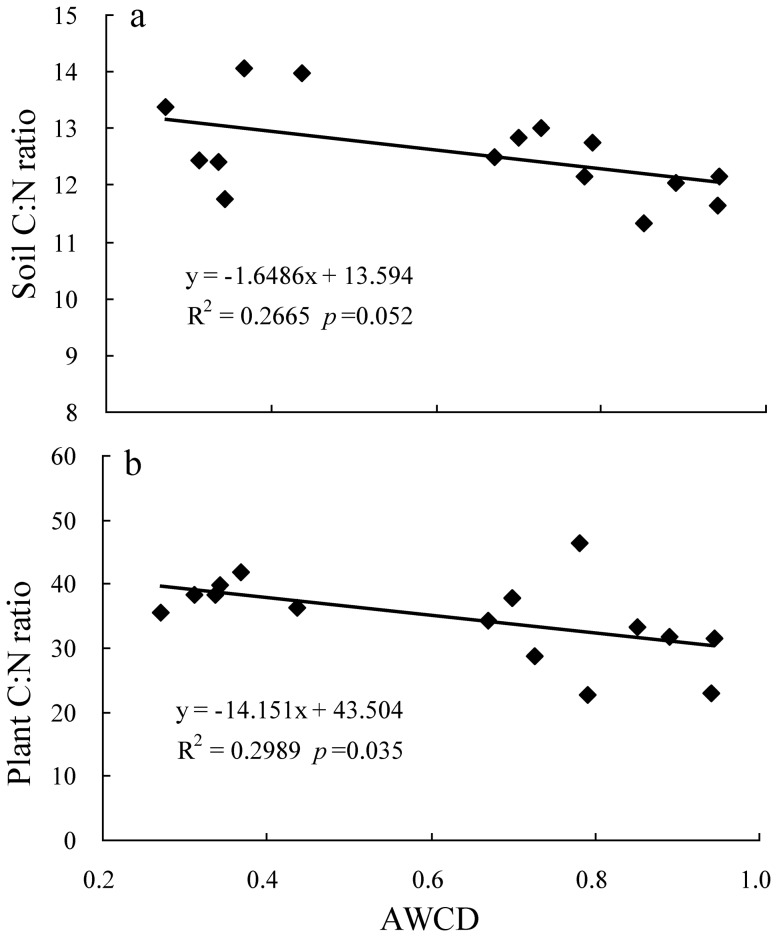
The relationships of AWCD of soil microbial community with soil C: N ratio (a) and plant C: N ratio (b) in July, 2012.